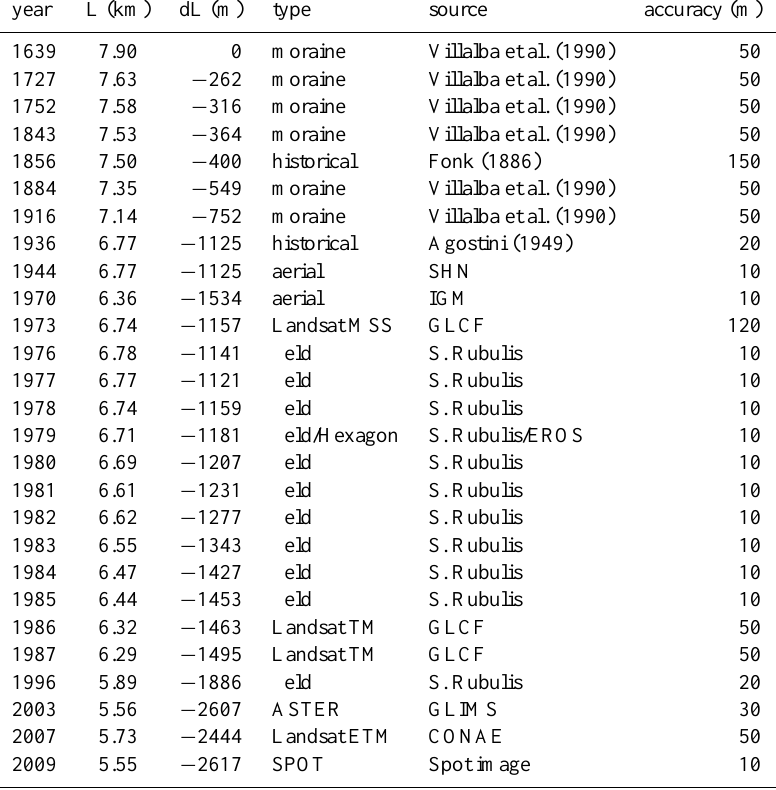
Table 1. Glacier length record of Glaciar Fr´ıas used in this study, including year of measurement (or reconstructed date of maximum extent), total length along the flowline (km), cumulative length change (m), method of observation ( moraine indicates a moraine dated with dendrochronology; historical are historical sketches and photos; field denotes field measurements of terminus position; and Landsat , Hexagon , SPOT and ASTER are positions measured from satellite images), data source, and estimate of accuracy of the length measurement